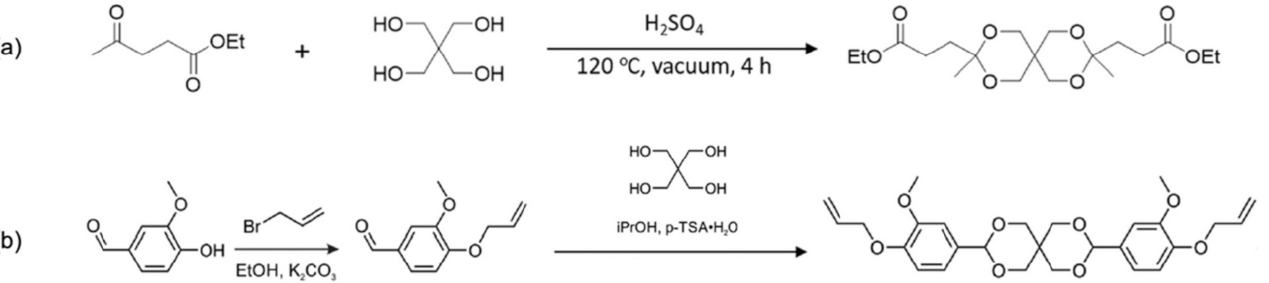
Figure 9. ( a ) Ketalization of levulinic acid and pentaerythritol for the synthesis of a cyclic polycon- densation monomer [168]. ( b ) Synthesis of a bio-based allyl ether monomer from vanillin